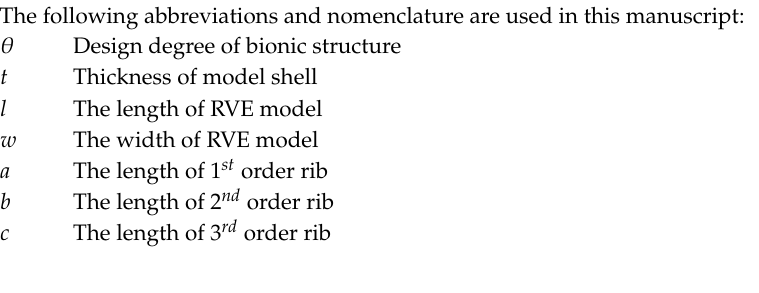
Figure 17. The application of bionic structure in pallet.